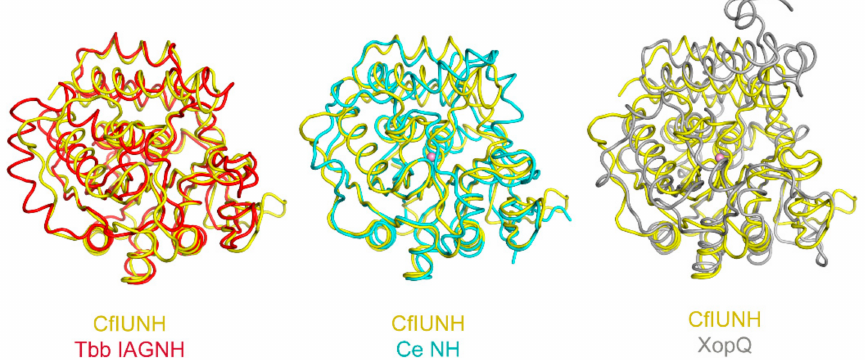
Figure 6. Structural comparison between NH proteins. Pairwise superposition of the T. brucei brucei IAG-NH (red), C. elegans NH (cyan), and X. oryzae XopQ onto the C. fasciculata IU-NH (yellow) highlights the conservation of the core b-sheet, while the surrounding secondary structural elements assume diverse orientations, affecting their activity and